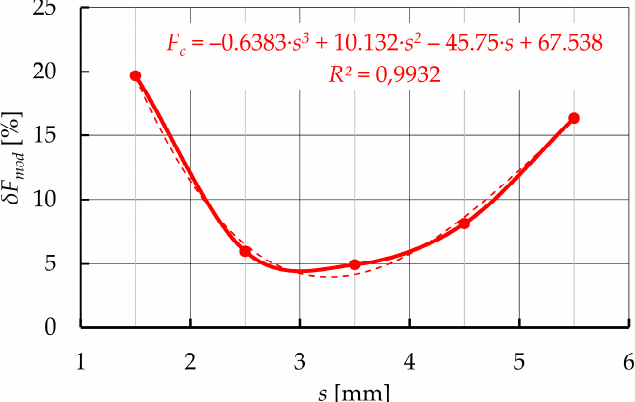
Figure 20. Examples of the characteristics of the plasticization force F pl ( s ) concerning the aspect of comparison between the values of empirical research ( F pl_exp ) and the derivative model ( F pl_mod ): ( a ) belt with diameter of 12 mm, hot plate temperature T p = 285 °C, plasticization velocity v pl = 10 mm/min, ( b ) belt with diameter of 18 mm , hot plate temperature T p = 285 °C, plasticization velocity v pl = 8 mm/min.